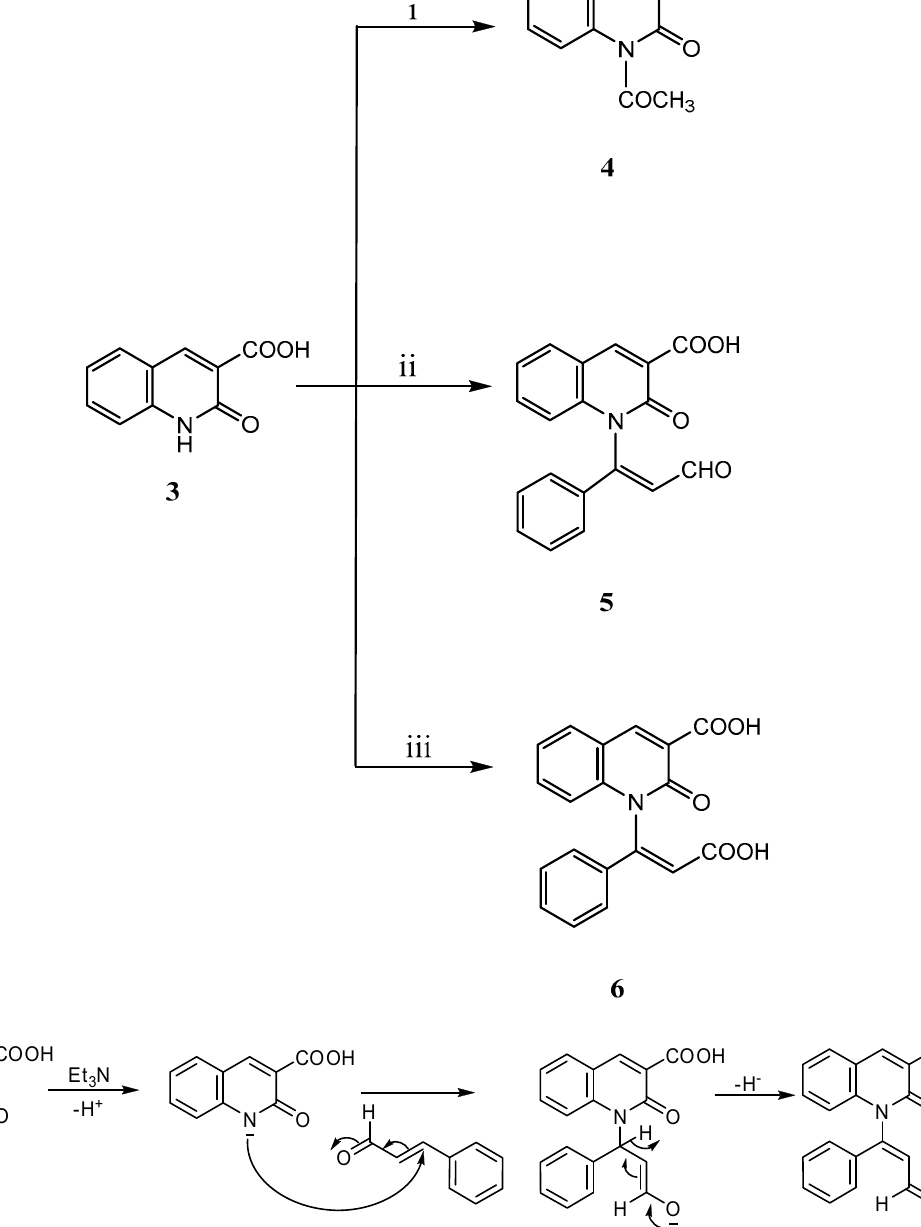
Scheme 2. Synthesis of 1 -N -(substituted)-azacoumarin-3-Carboxylic acids ( 4 – 6 ). Reagents and reaction conditions: (i)